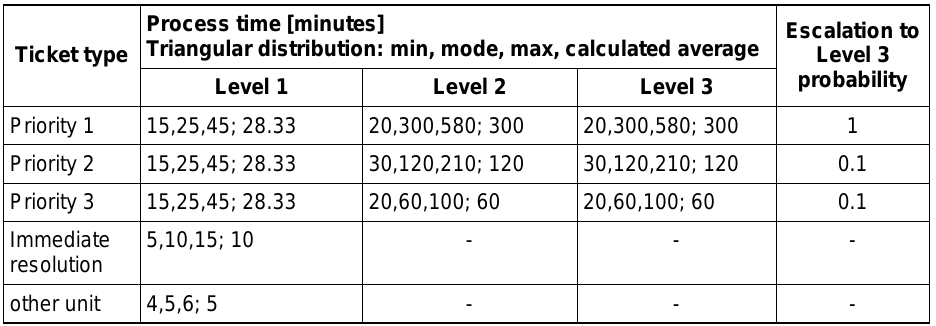
Table 2 – Service process time parameters and escalation